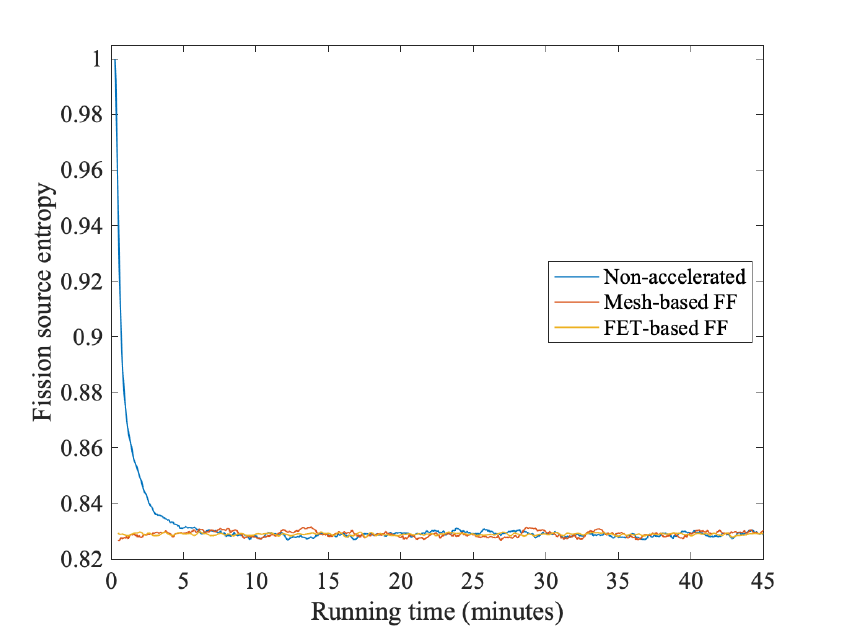
Figure 4: Axial fission source entropy for single-assembly test